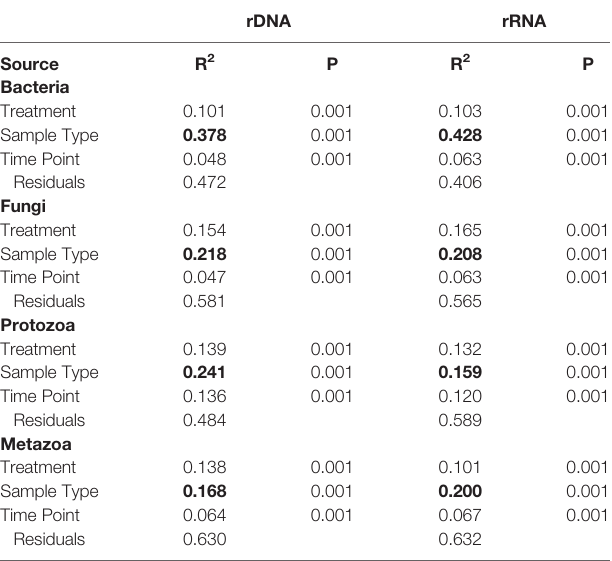
TABLE 2 | The impact of three variables on the resident and the active fractions of four organismal groups in fi elds with three soil management regimes with pea as main